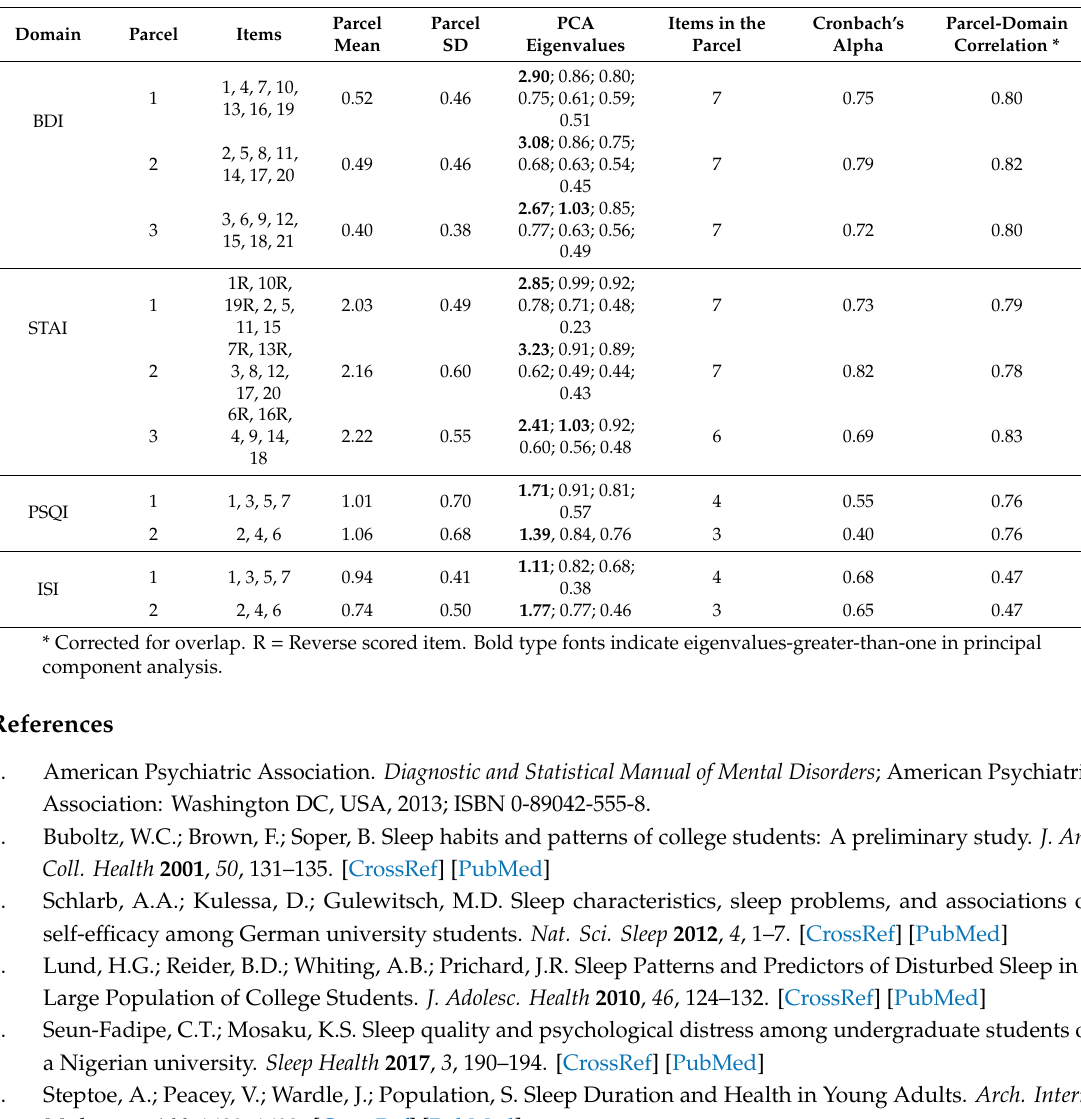
Table A1. Assessment of unidimensionality and convergence of the parcels used to measure the latent variables in structural equation